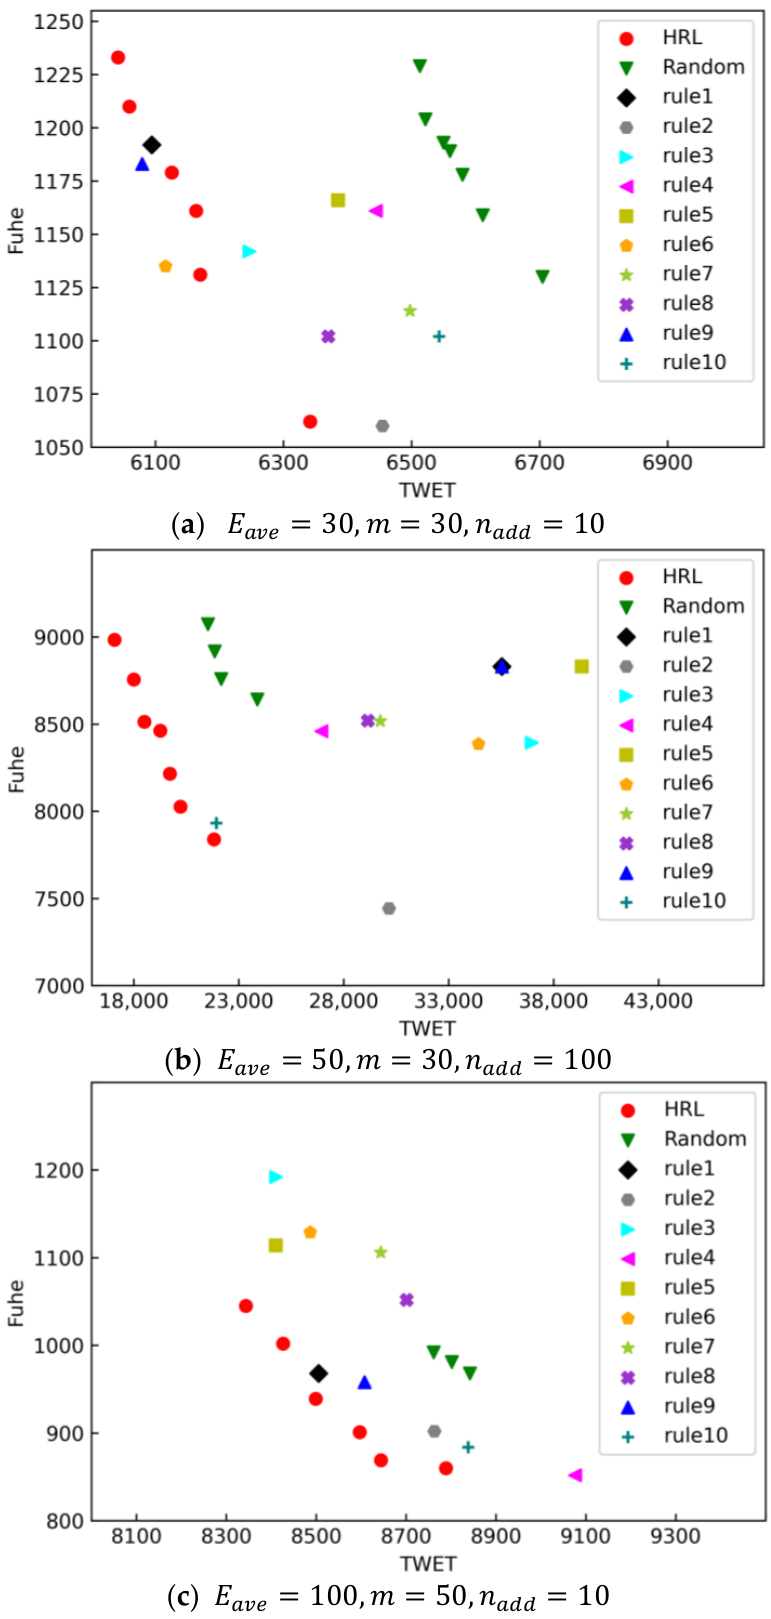
Figure 4. The Pareto fronts obtained by the comparative methods for some representative produc- tion instances.